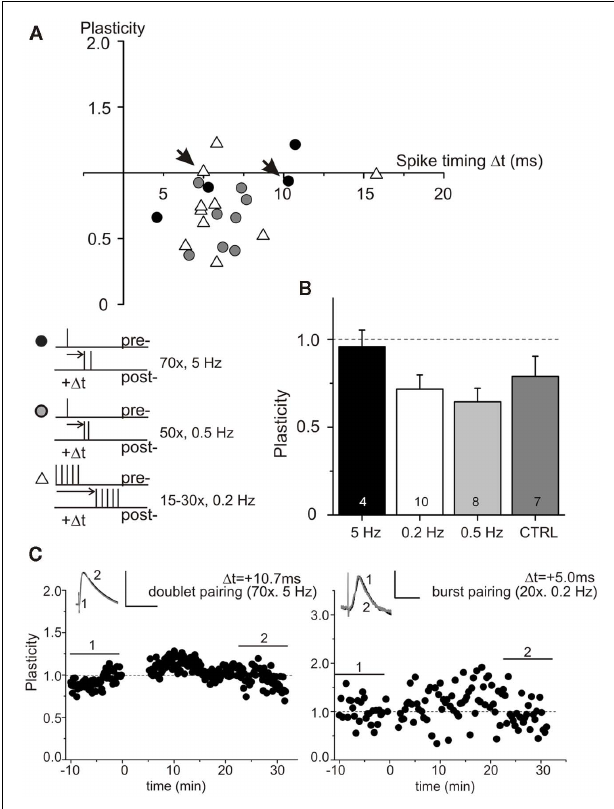
FIGURE 4 | Spike timing-dependent plasticity deficiency is not restored by stronger STDP inducing paradigms. Experimental conditions as in Figure 1 . STDP could not be rescued in sucrose prepared hippocampal slices, when using 50 or 70 pairings of one presynaptically evoked EPSP and two postsynaptic spikes with 3ms interspike interval paired at 0.5Hz (gray dots), or with 10ms interspike interval paired at 5Hz (black dots), or when using 15–30 burst stimulations consisting of 5 successive EPSPs paired with 5 evoked action potentials at 0.2Hz (open triangles), respectively (A) . Respective data for the different paradigms are summarized in (B) . Results from individual experiments are shown in (C) for doublet pairing (left), and repetitive burst pairings (right).The corresponding cells are indicated with arrows in (A) . Bar scales: 10mV, 50ms (left), 5mV, 50ms (right).